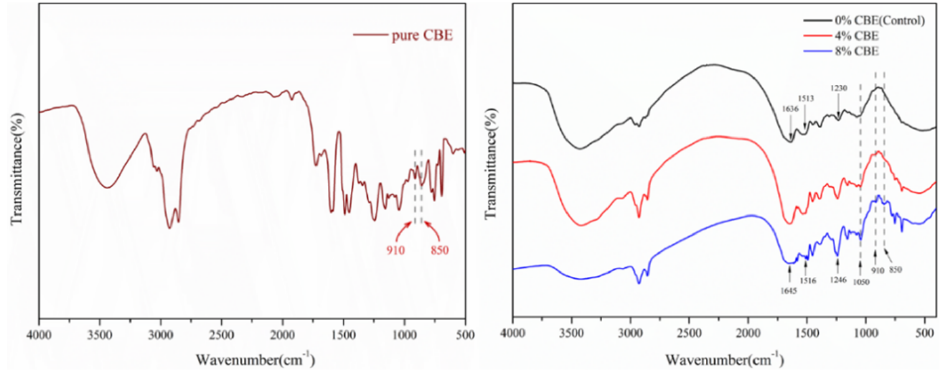
Figure 4. FTIR spectra of CBE and soybean protein-based adhesives with different CBE content.